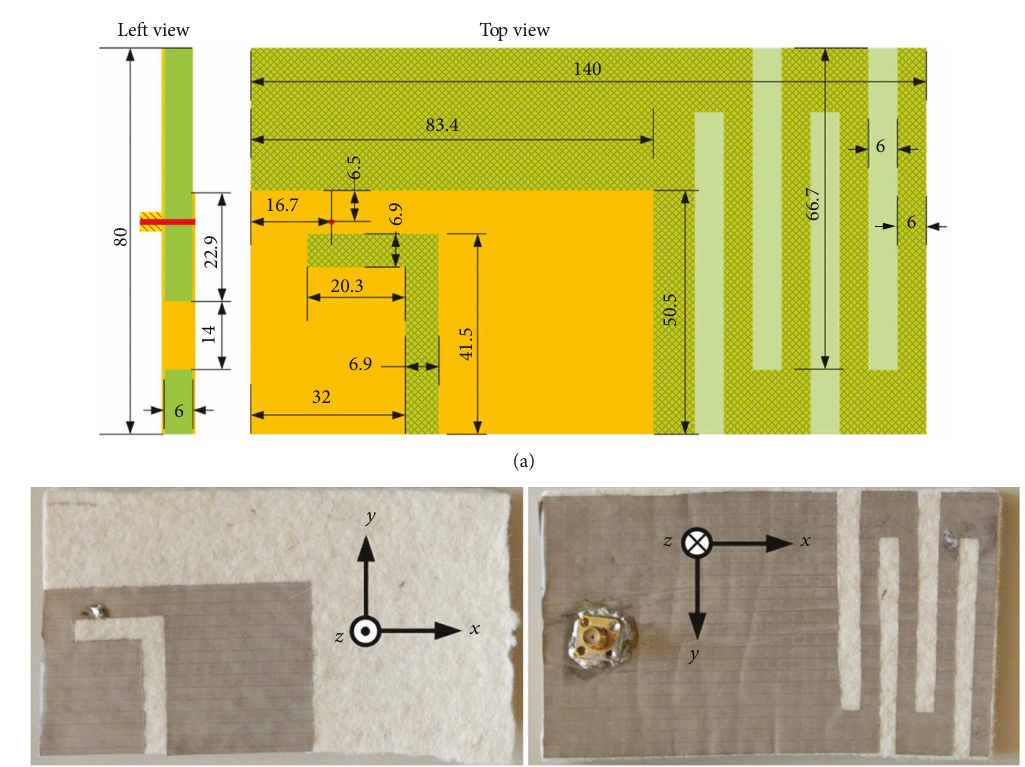
Figure 4: A dual-band PIFA antenna for the ISM band